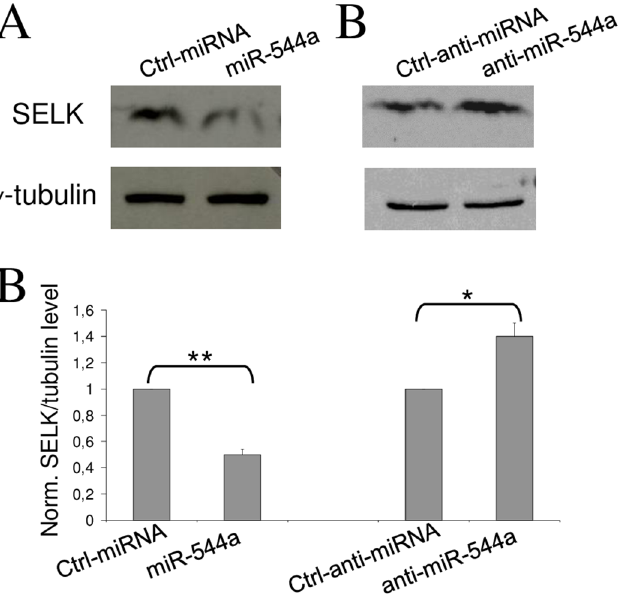
Fig 4. The silencing effect of miR-544a on SELK in HuH-7 cells. Representative Western blot analysis of protein extracts at 48 h after transfection with miR-544a mimic (A) or miR-544a inhibitor (B) and their relative control molecules at 50 nM. (C) Quantification of SELK protein band normalized to that of tubulin; signal intensity values determined for the control experiments (Ctrl-miR and Ctrl-anti-miR) were set at 1; values represent the mean ± s.d. of three independent experiment. P-values are indicated as described in Fig 3.